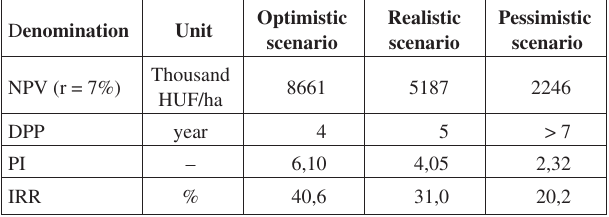
Table 8. Investment Efficiency in Hungarian Apple Production Regarding Investment Subsidies